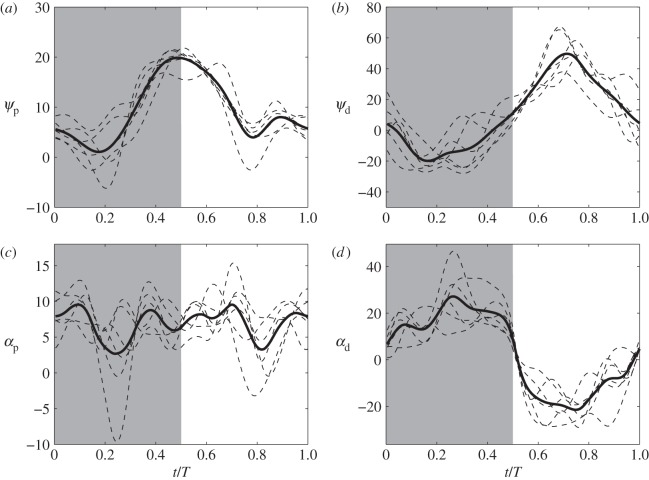
Chord angle ψ (a,b) and effective angle of attack α (c,d) for a proximal chord at r^=0.15 (a,c) and a distal chord at r^=0.90 (b,d).